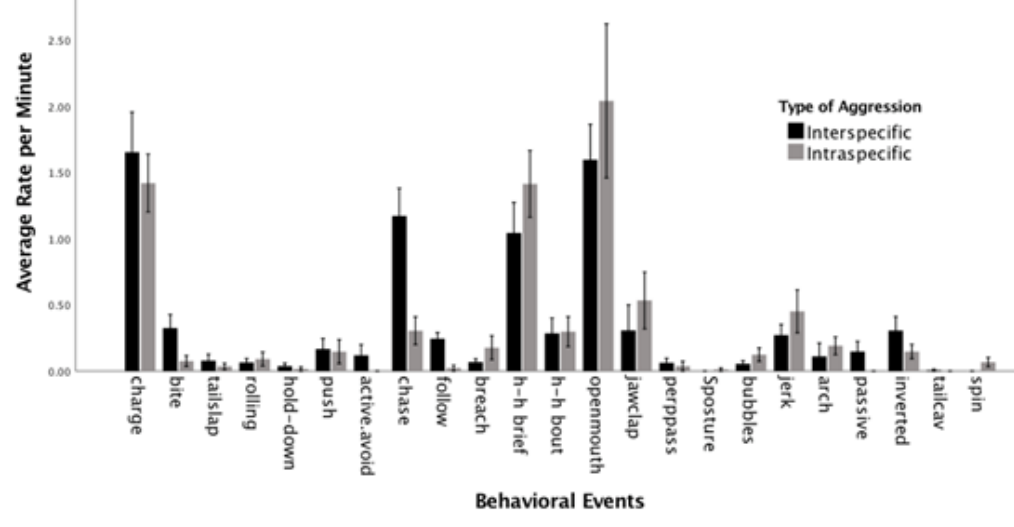
Behavioral Events Observed During Either both types of Aggression, only Interspecific, or only Intraspecific Interspecific & Intraspecific Interspecific Intraspecific Arch Actively Avoiding Side-mounting S-Posture Bout of H-H Passive Spinning Brief H-H